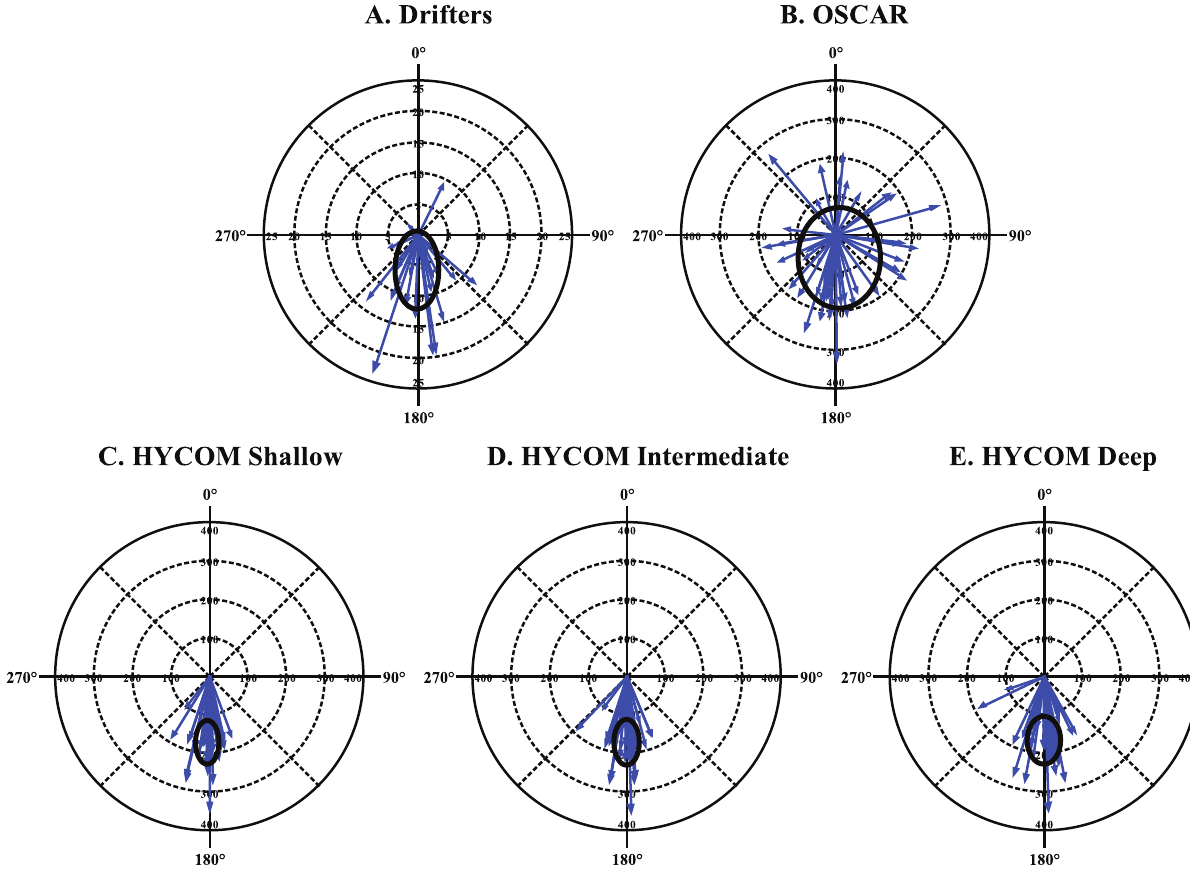
Figure 5. Individual vector representation of all 42 satellite tagged turtle movement showing the difference between the swimming vector and the current vector for each of the 5 currents examined. Each vector represents the average difference for that individual with the length of the vector proportional to the number of days at liberty for each individual. The swimming direction differencing to currents is a relative direction where North is the direction of the current and South is against the direction of the current. The standard deviation ellipse is also plotted, which represents the resultant vector per panel as a centroid of an ellipse with dimensions of standard deviations of direction differences and days at